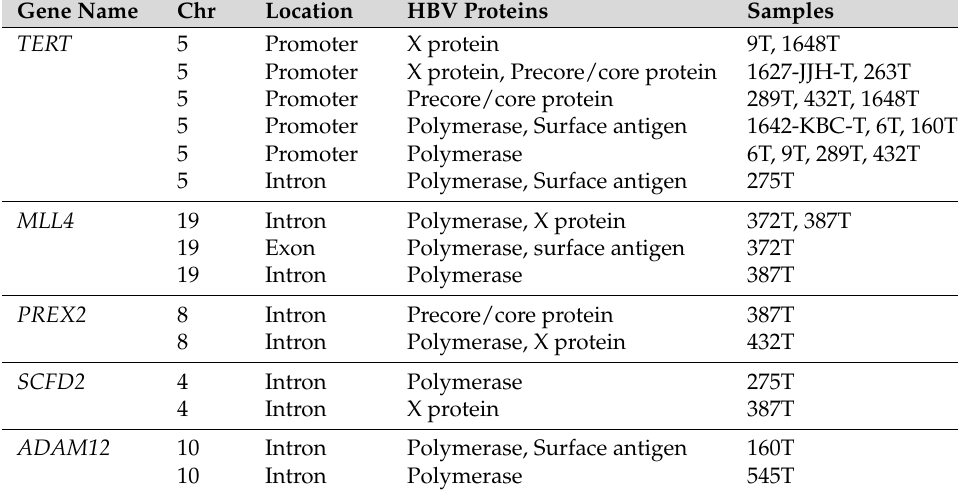
Table 2. Recurrently targeted genes with HBV integration in